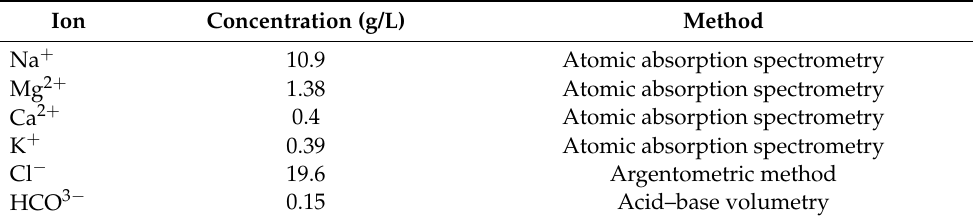
Table 1. Ionic concentration of seawater and methods of analysis.